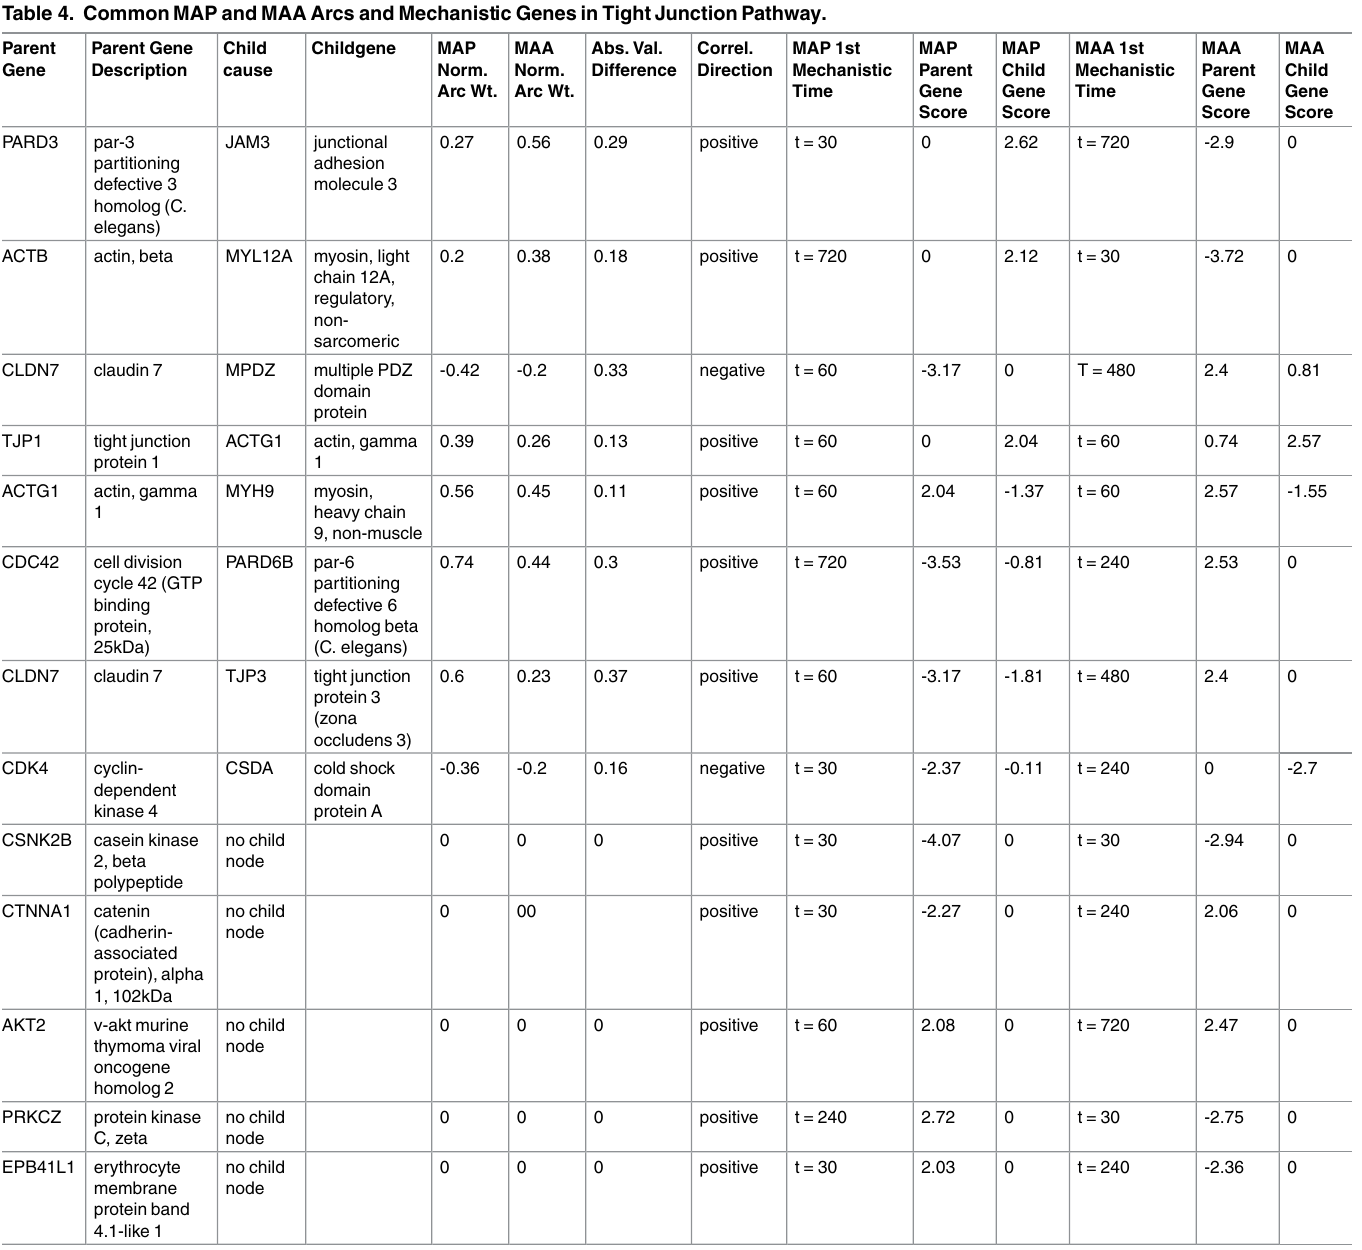
Tight Junction Pathway Bayesian Model Interrogation Results of Gene-to-Gene Relationships and Mechanistic Genes found in commonbetween the MAP and MAA conditions. See text for descriptionof interrogation